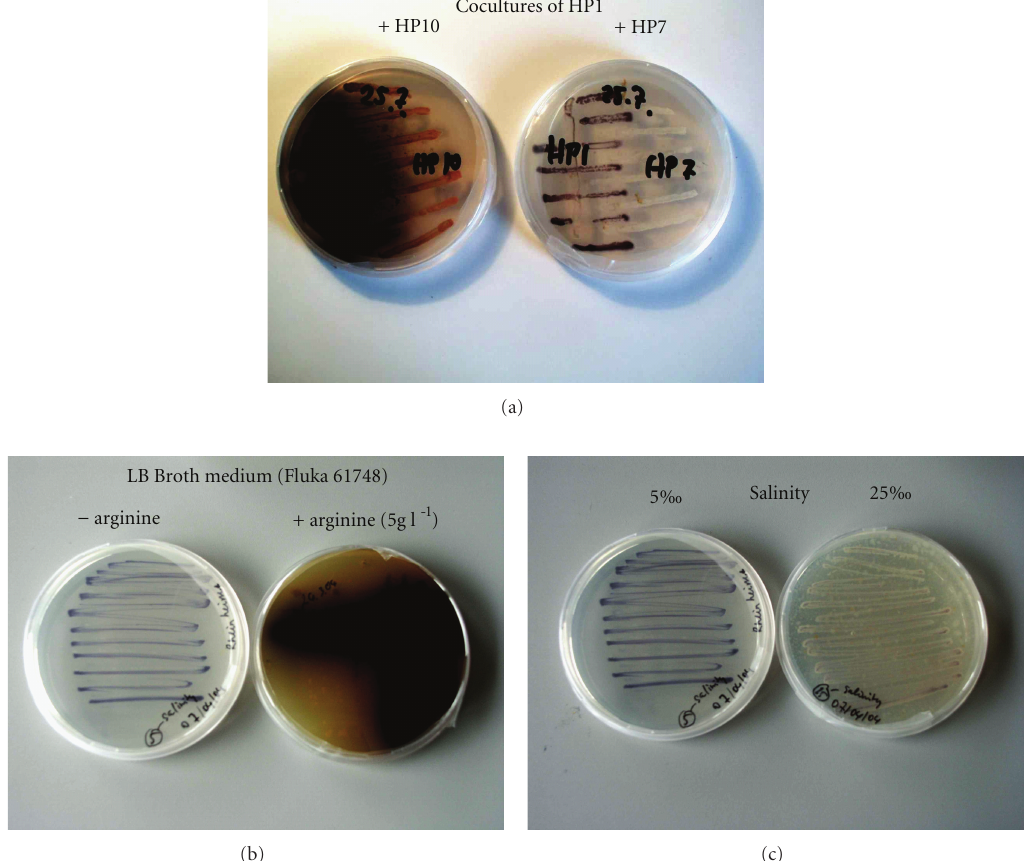
Figure 3: Production of the glaukothalin by Rheinheimera sp. strain HP1 (a) grown on Marine Broth (MB2216) medium in the presence of HP10 or HP7 (note the intense production in the presence of HP10), (b) grown on LB Broth medium (Fluka 61748) at 5‰ salinities either without or with the amino acid arginine (5g L − 1 ), (c) grown on LB Broth medium at salinities of 5‰ and